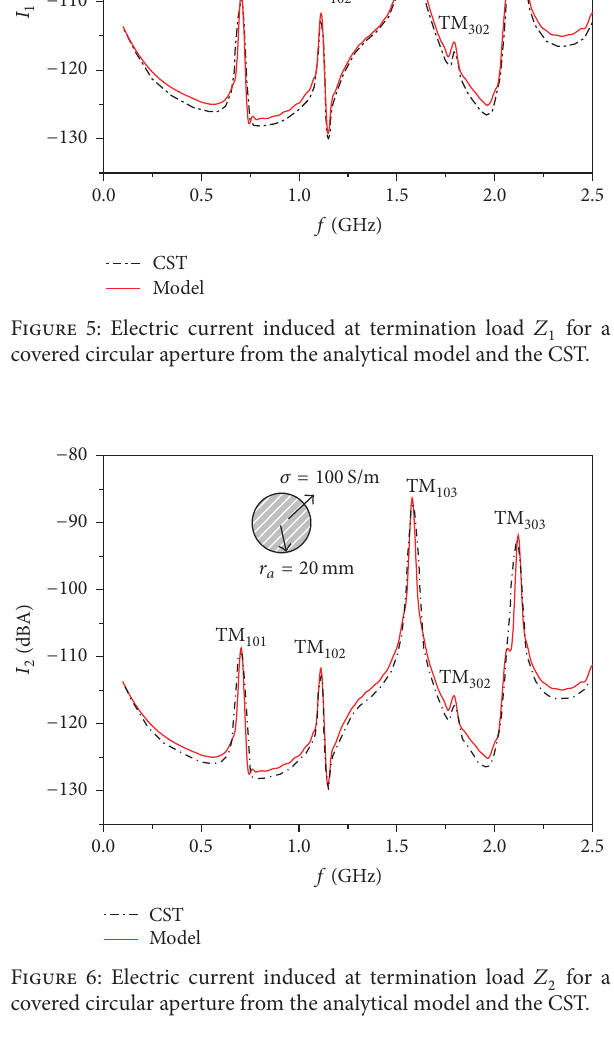
Figure 6: Electric current induced at termination load 𝑍 2 for a covered circular aperture from the analytical model and the